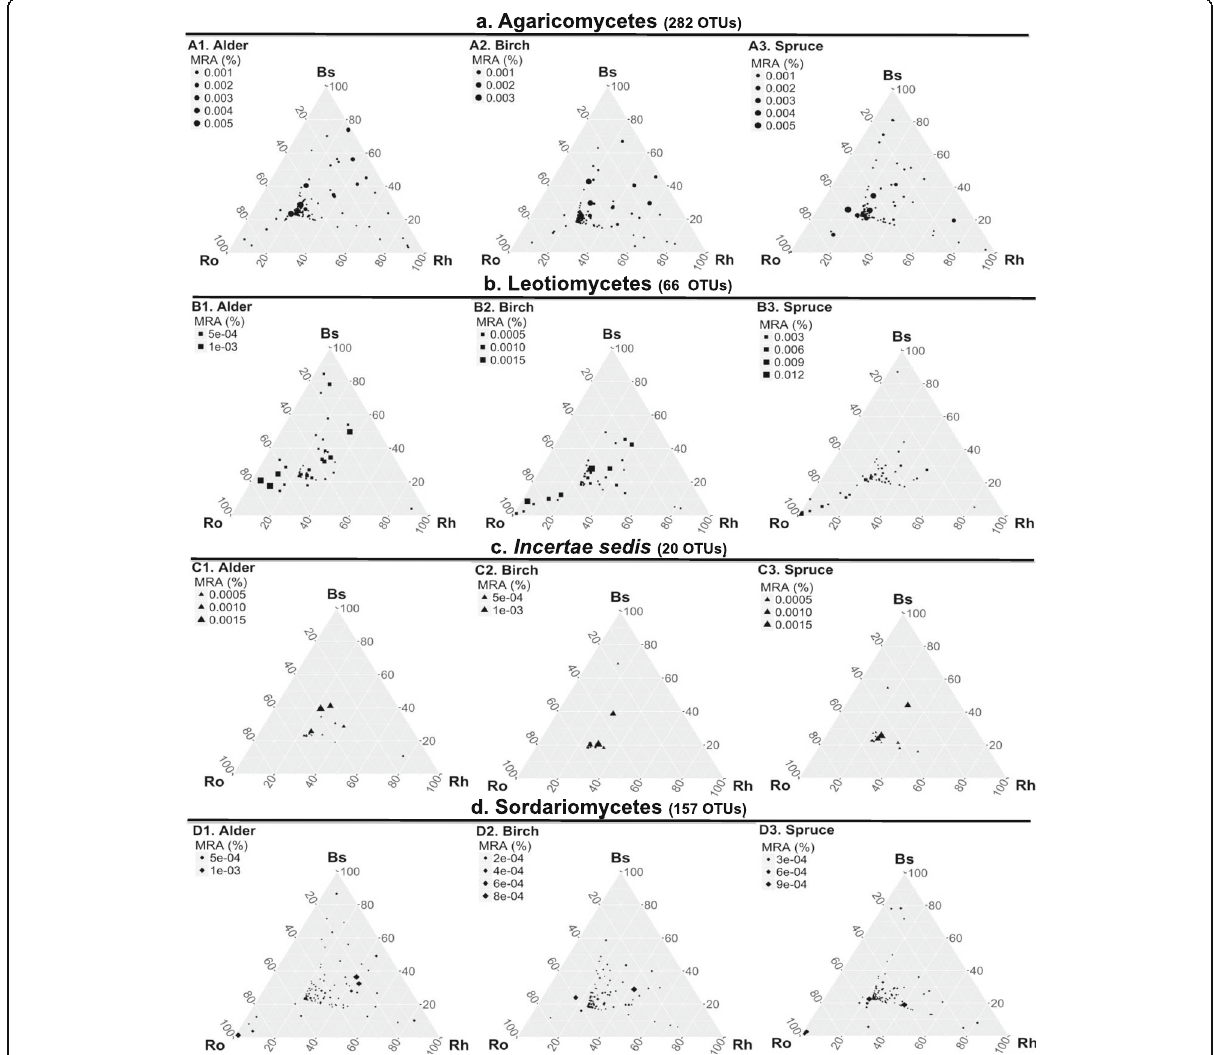
Fig. 6 Ternary plots of mean relative abundances (MRAs (%)) of the 4 most abundant fungal classes (which are not “ other ” ). Each point is an OTU whose position is indicative of its MRA in bulk soil (Bs), the rhizosphere (Rh), and roots (Ro) of alder, birch, and